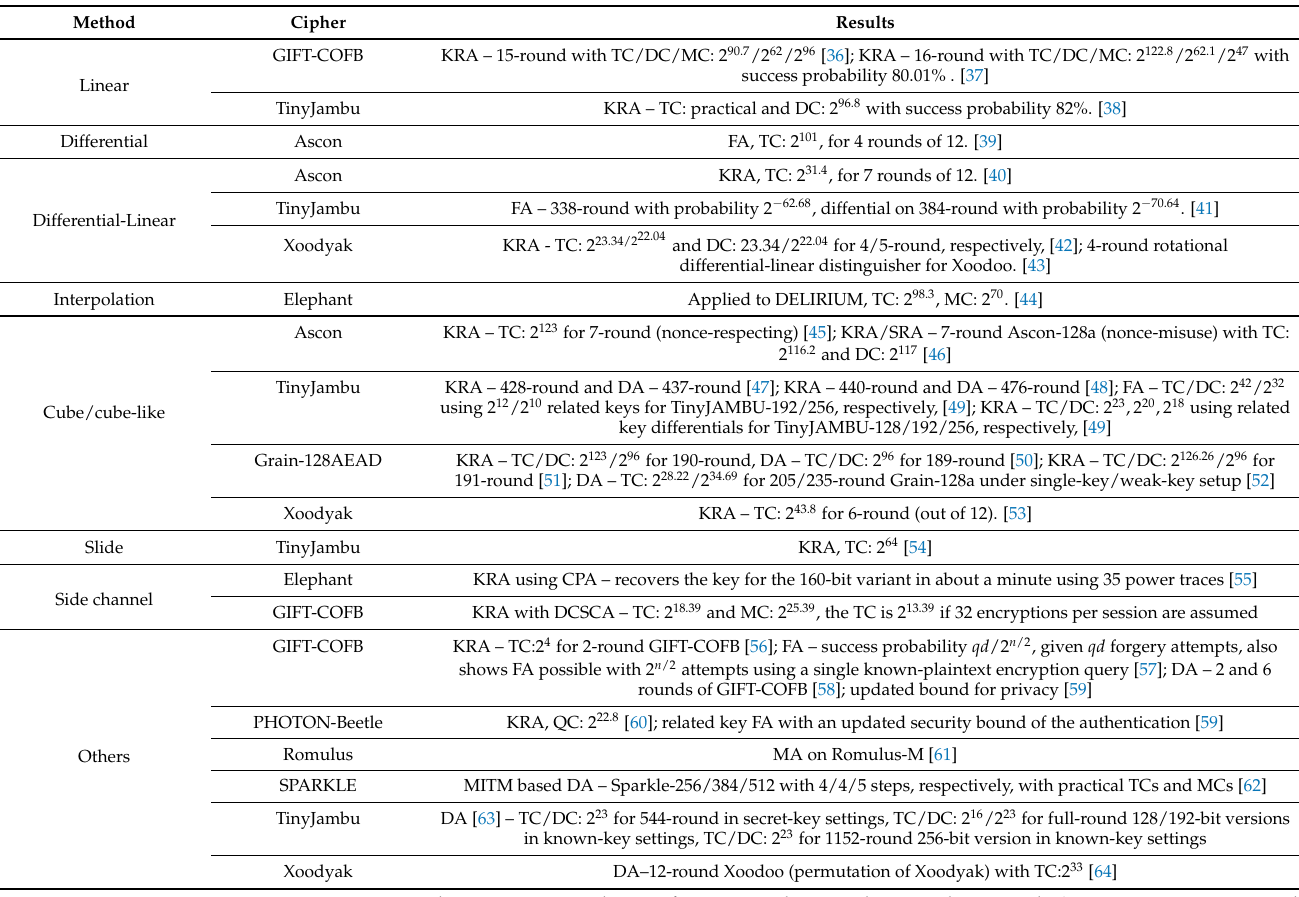
Table 2. Summary of known analyses of the finalist